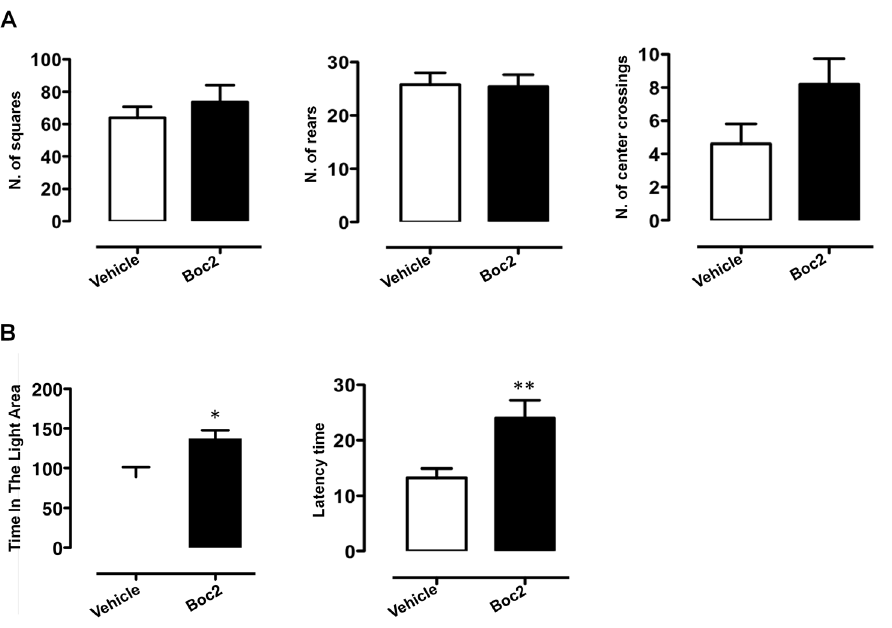
Fig. 7. Boc2-treatment reduces anxiety-like behaviour in C57BL/6 mice. The bar graphs in A show the total number of squares crossed, rears and centre crossings of Boc2-treated mice compared to PBS vehicle- treated during a 5-minute trial in the open field test. The bar graph in B shows the total time (seconds) spent in the lit area and the latency (seconds) to first cross to the dark chamber of Boc2-treated mice compared to PBS vehicle-treated mice during a 5-minute trial. Values are expressed as median ¡ S.E.M. and representative of four different experiments involving 6 mice per group. * P , 0.05 and ** P , 0.01 indicate significant values compared to PBS-vehicle treated mice (Mann–Whitney U -test).